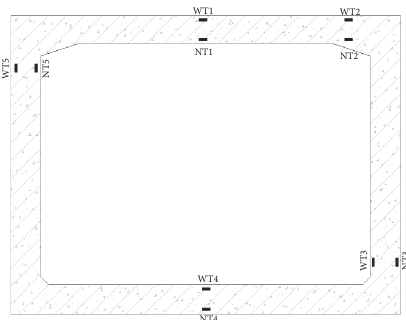
Figure 4: Layout diagram of concrete stress gauges of 1-1 profile ∼ 3-3